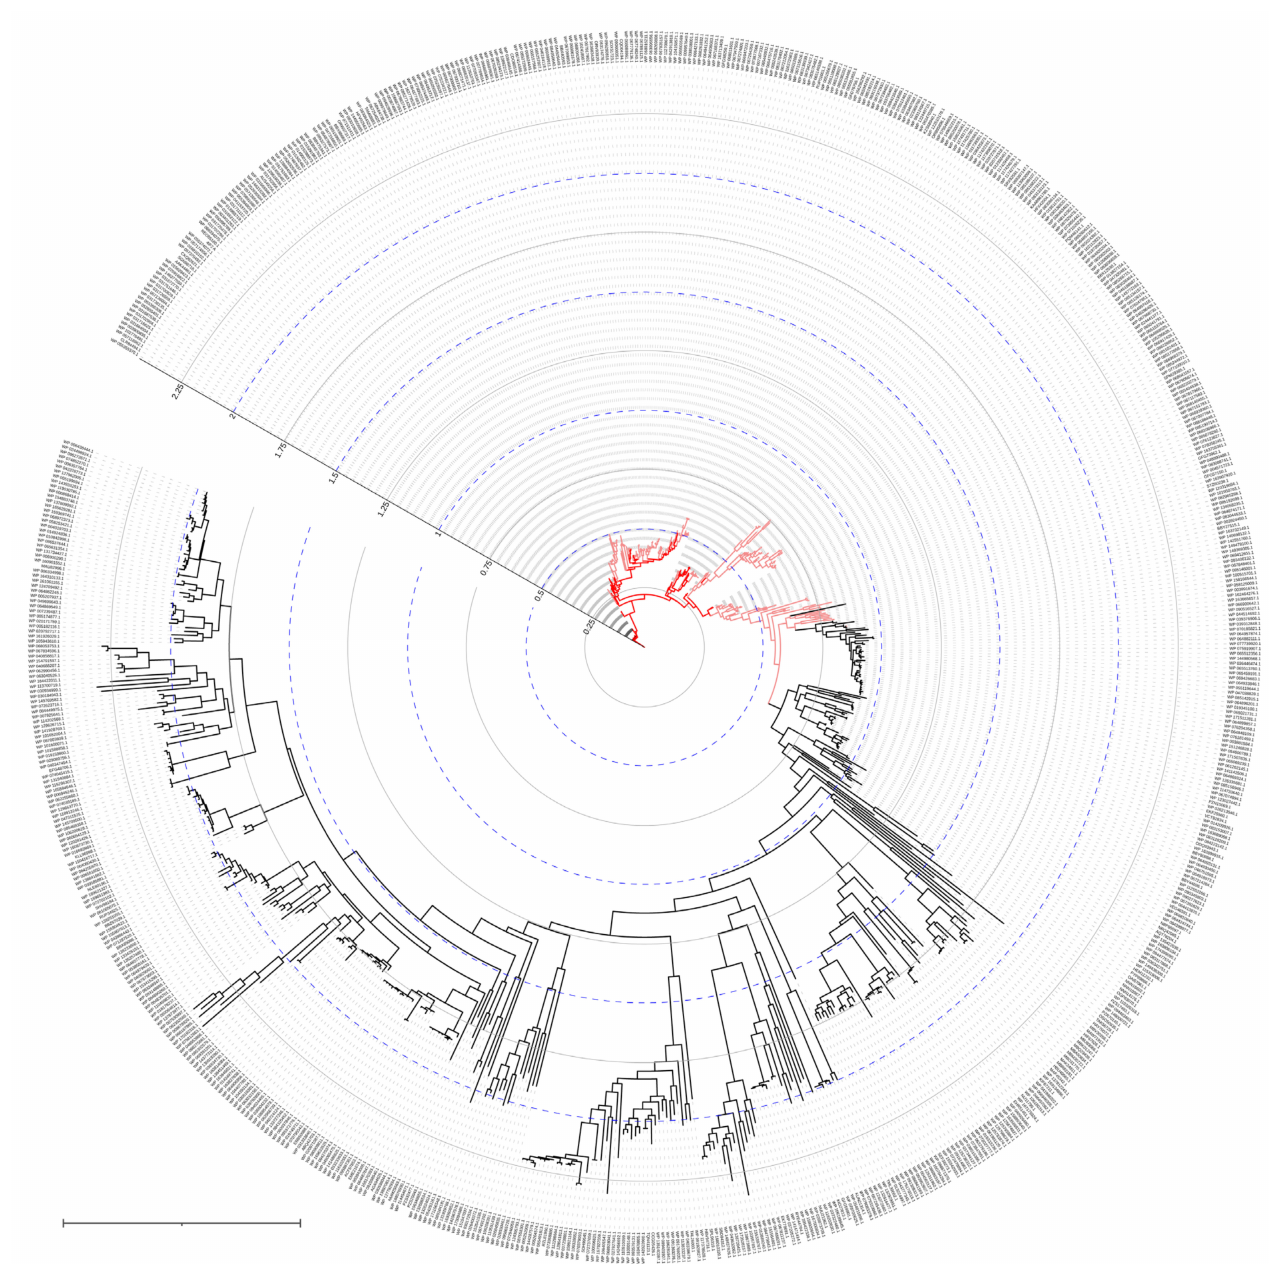
Figure 6. Phylogenetic tree of mPHP and its homologous enzymes (down to 55% identity). The tree was built as previously with PDB 4IF2 as a reference sequence. Enzymes having high (90–100%) and good (80–89%) identity are highlighted with red and pink,